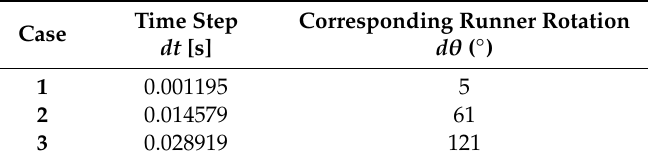
Table 3. Time step sensitivity